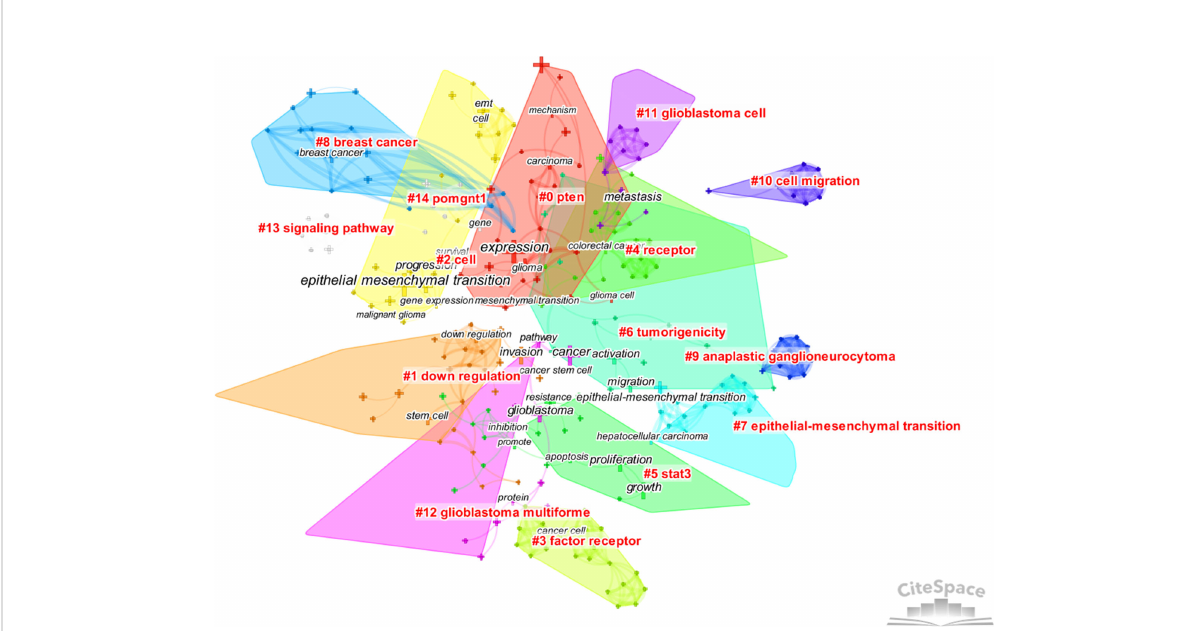
FIGURE 4 The cluster map of keywords. Pruning functions included path fi nder, pruning sliced networks, and pruning the merged networks. LLR algorithm was